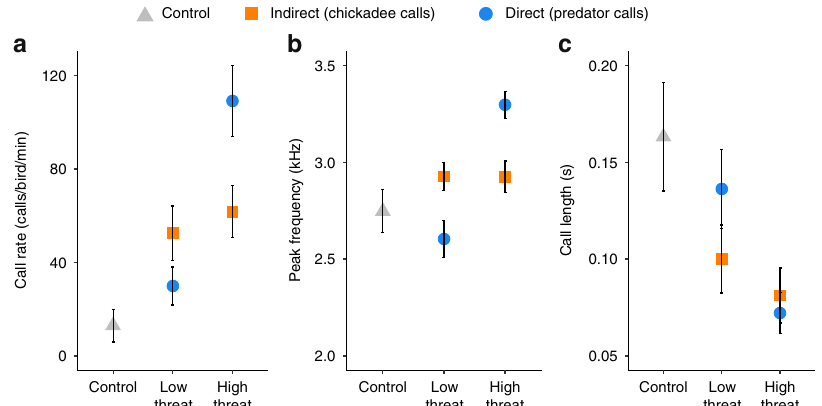
Fig. 2 Acoustic features in response to predator threat and information source. Acoustic parameters of nuthatch mobbing calls depend both on the threat level of the predator and the source of the information. Mean ± standard error of red-breasted nuthatch a call rate (calls/bird/minute), b peak frequency (kHz), and c call length (s) of mobbing calls produced in response to control (grey triangles), direct information (blue circles), and indirect information (orange squares). Source data are provided as Supplementary Data 1.